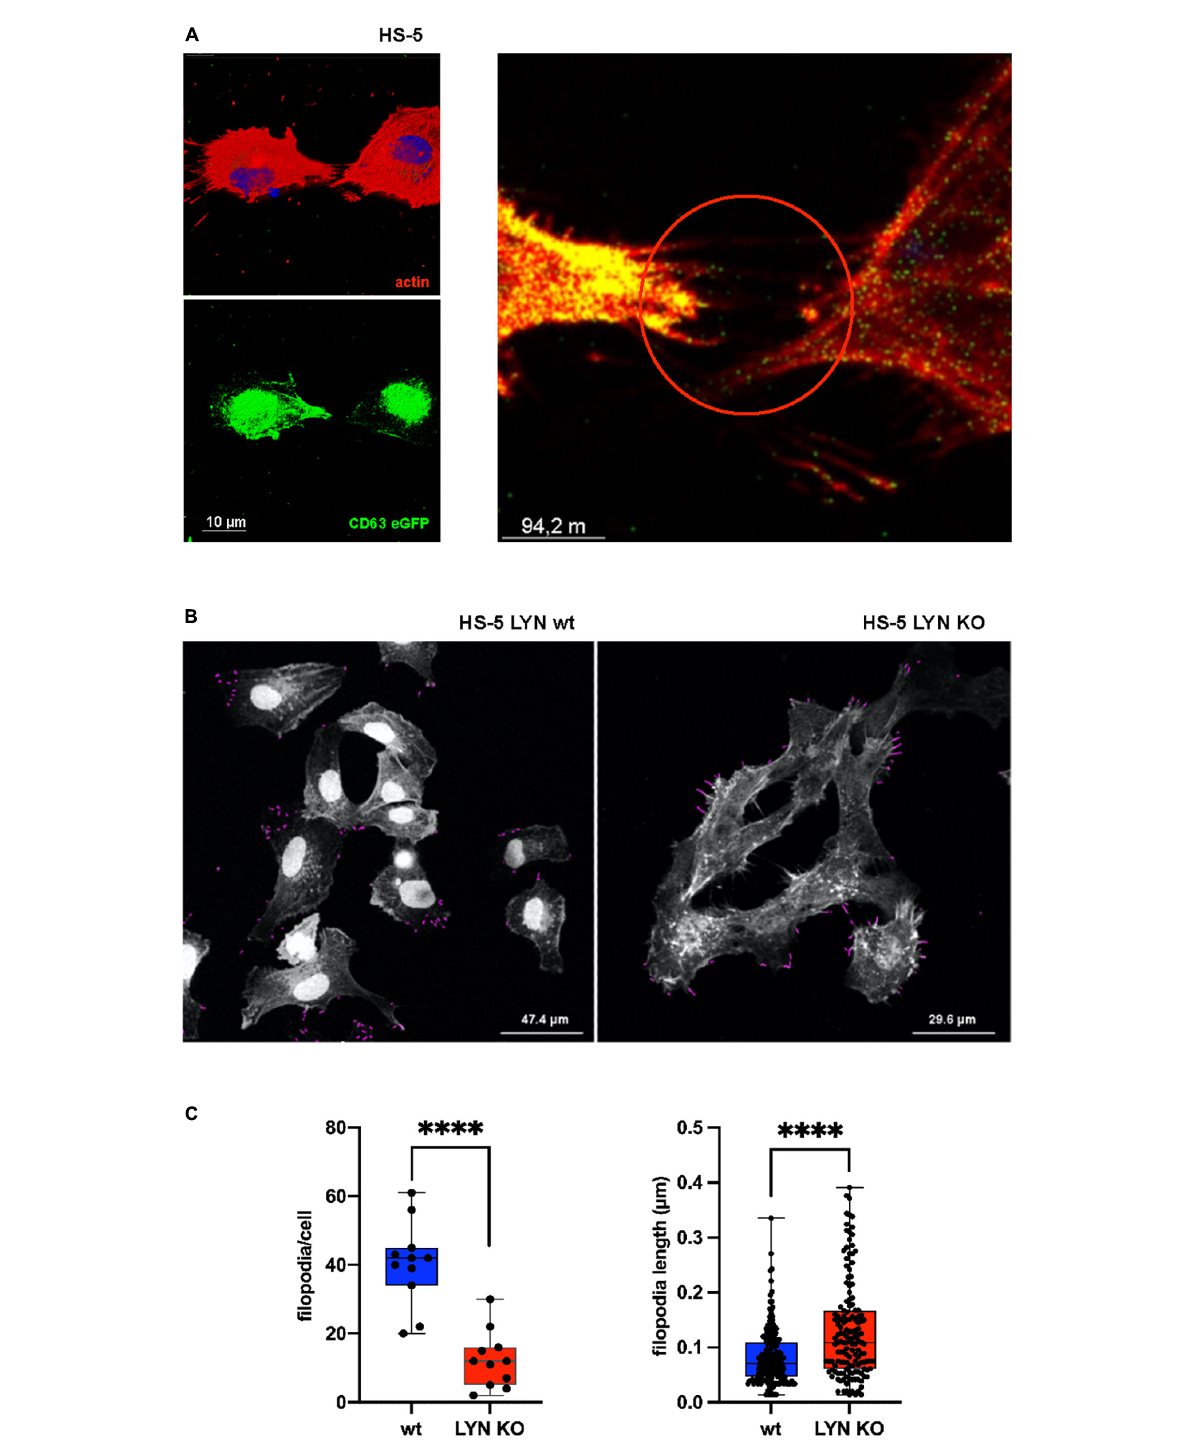
FIGURE4 Influence of Lyn on filopodia in stromal cells. (A) wt HS-5 cells were transfected with CD63-eGFP and grown to confluency. Then, cells were treated with Alexa Fluor Phalloidin (594) to stain F-actin. Images with single stains and a fused image are depicted. Arrow heads show protrusion-associated CD63 + extracellular vesicles (EVs). (B) Filopodia were identified in Lyn-proficient and -deficient HS-5 cells after F-actin staining. Filopodia were measured and calculated in fixed cells using the FiloQuant plugin of Fiji software (19). (C) Filopodia count per cell and filopodia length were determined. The results were statistically evaluated by a two-tailed, unpaired, non-parametric t -test (Mann–Whitney) ( ∗∗∗∗ P <